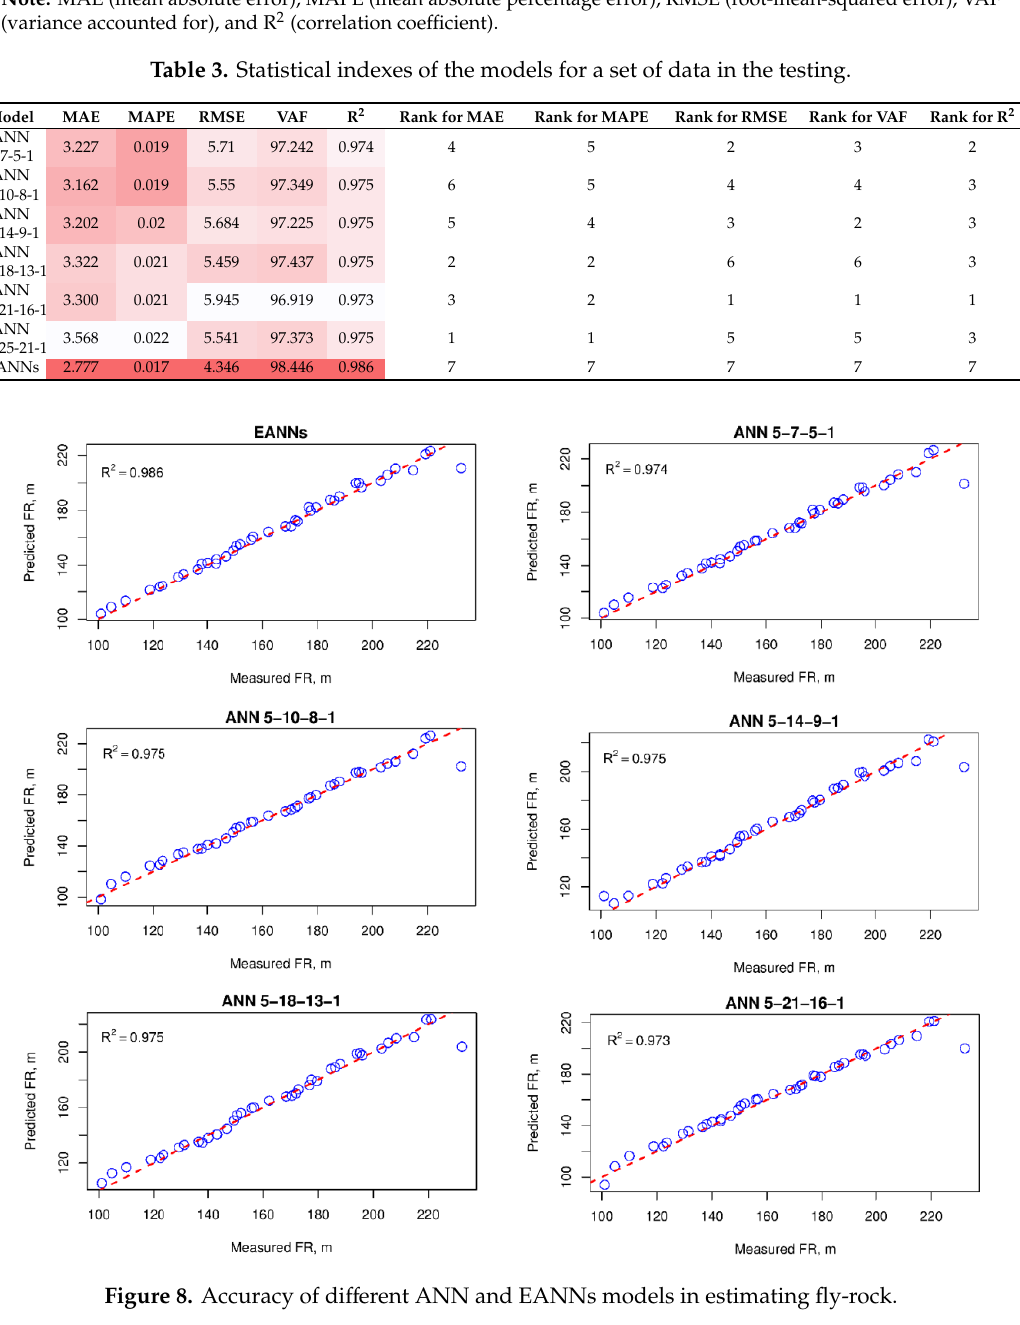
Figure 9. Comparison of the proposed EANNs and ANN models with the same structure. Although the EANNs’ performance is outstanding; however, the effects of the input parameters need to be taken into account to evaluate the importance of the inputs for predicting FR. Accordingly, the sensitivity of the input parameters was analyzed, as shown in Figure 10. Eventually, ST and W were found to have the most effect on the training of the proposed EANNs model, whereas the remaining parameters (i.e., PF, S, B) also affect the model, but not much.